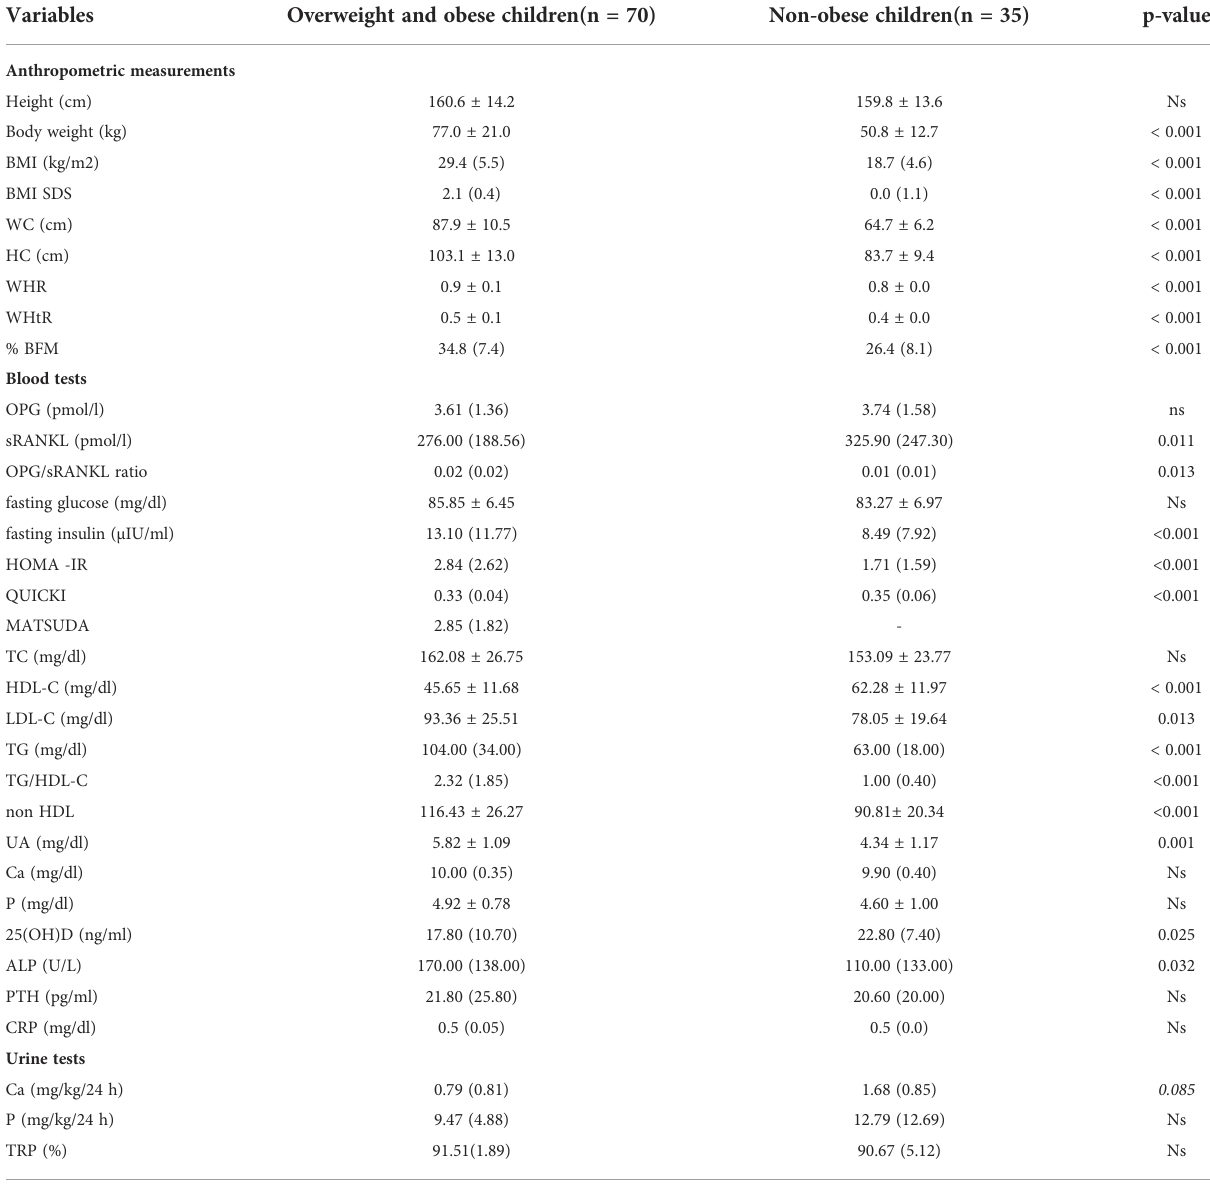
TABLE 1 The comparison of anthropometric measurements, OPG, sRANKL, and biochemical parameters between overweight and obese children and their peer with normal weight. Variables Overweight and obese children(n = 70) Non-obese children(n =